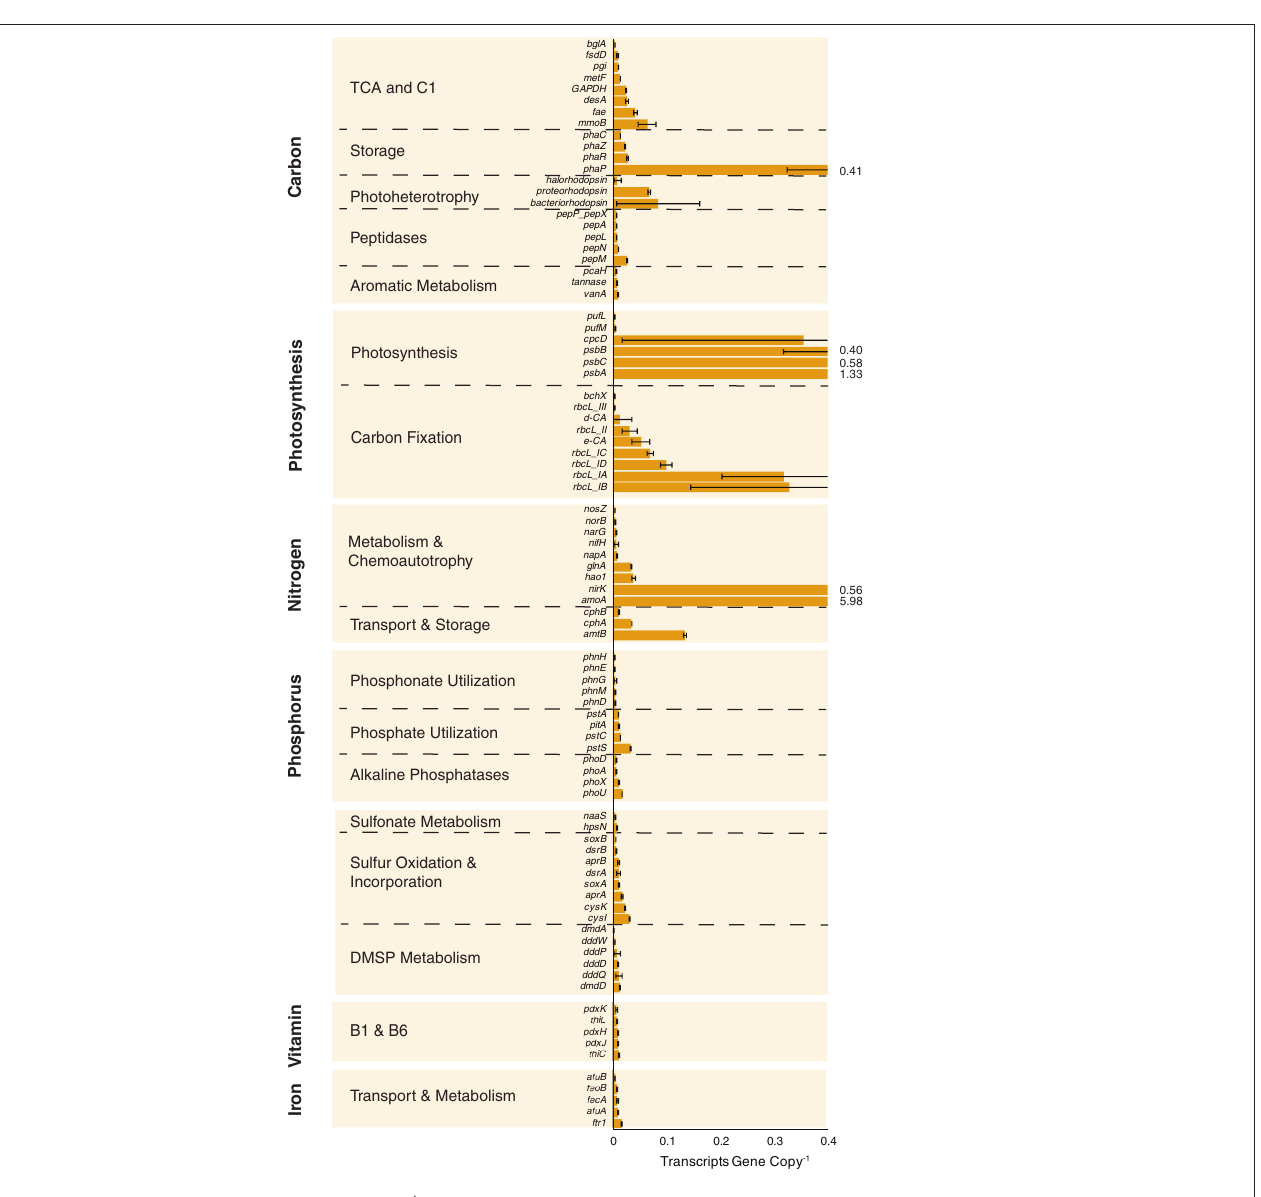
copy in any sample was amoA in the particle-associated fraction at BLM, at 14 transcripts gene copy − 1 ( Figure 3 and Table